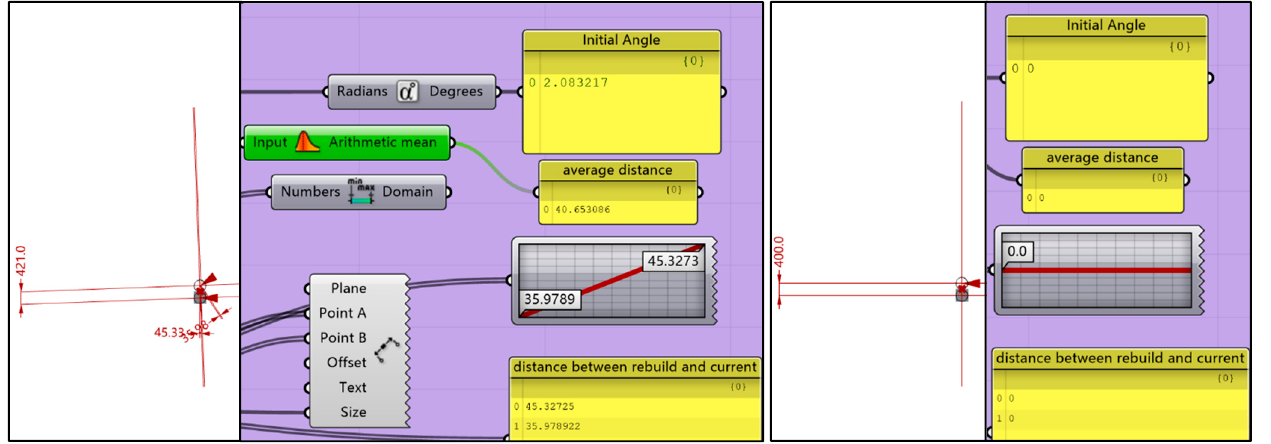
Figure 11. Verification of two columns (the disordered axes on the left, the result axes on the right).